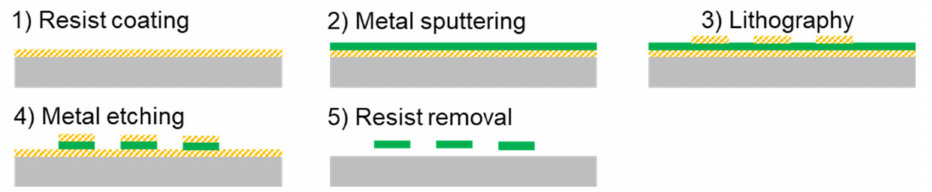
Figure 1. Fabrication technology to create free-standing samples of FeCuNbSiB by sputtering on